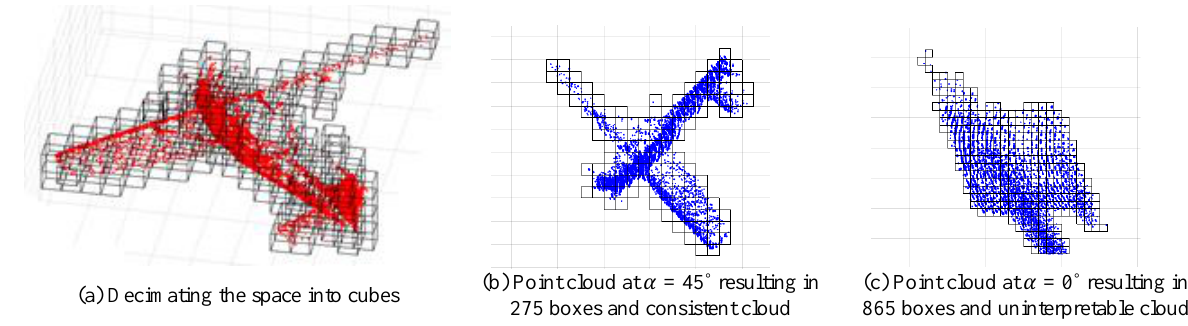
Figure 10. Examples for explaining the method of volume minimization Table 1. The implemented simulated annealing algorithm for finding the mimimum volume respect to the headin and velocity, the convergence of the parameters are in the right